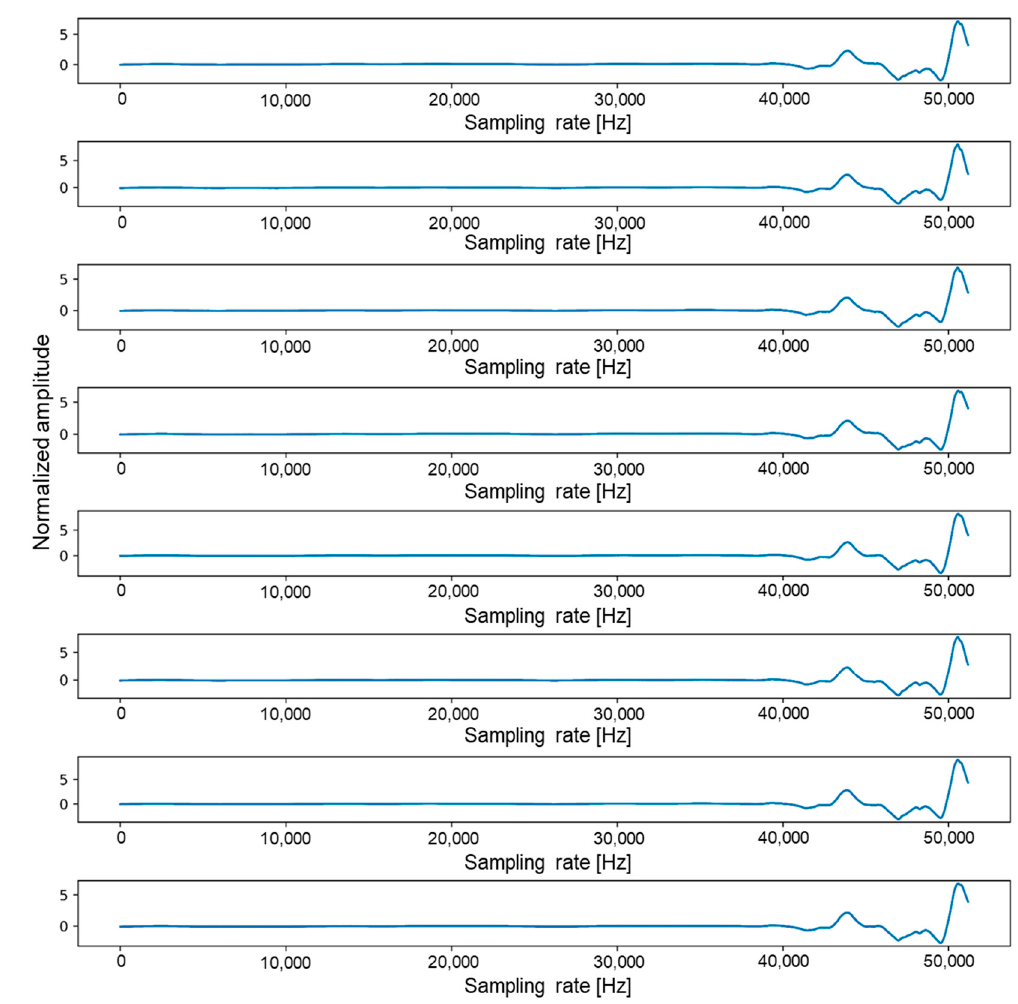
Figure 2. Structure of an acoustic dataset with a size of (51,200 × 8).